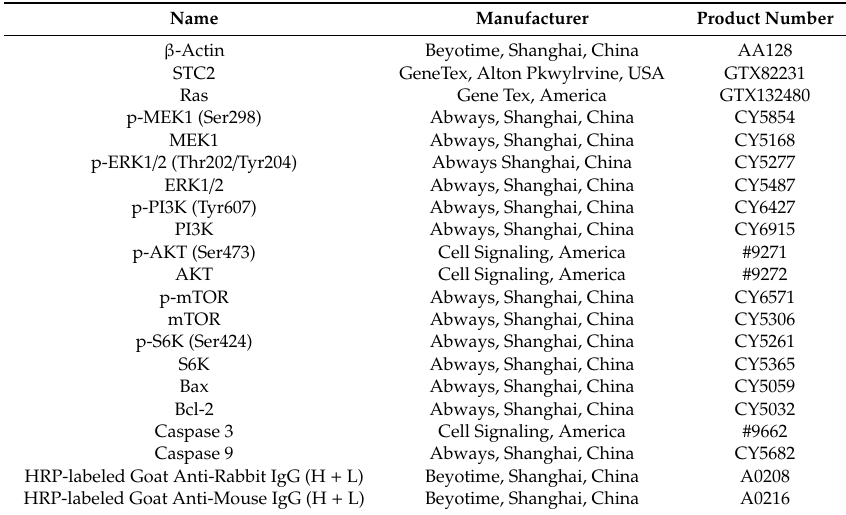
Table 1. Antibody used in this